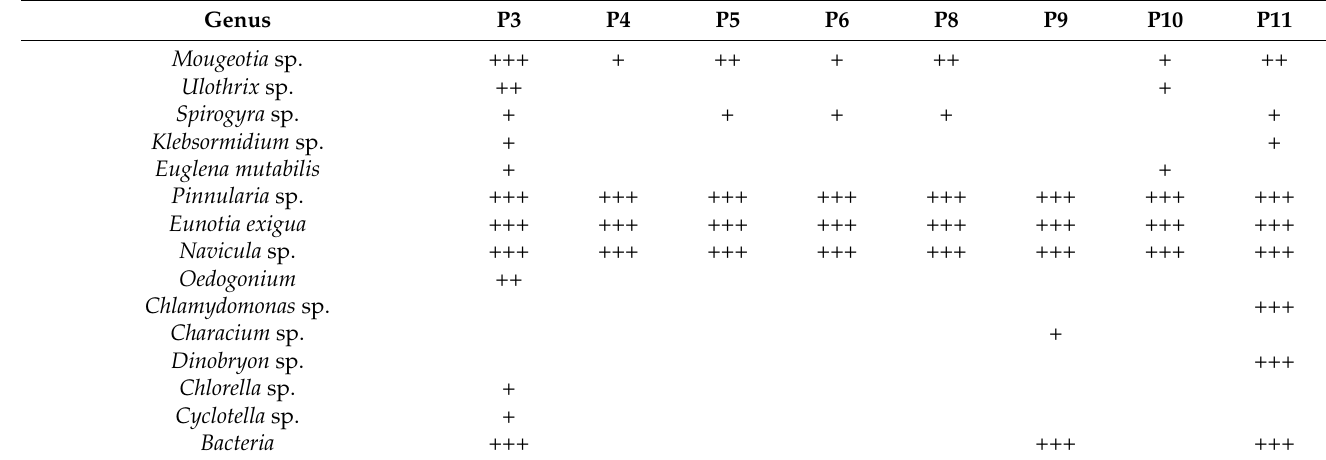
Table 2. Taxonomic classification of the identified material in the effluent collected through the year. +++ very abundant ++ abundant + isolated